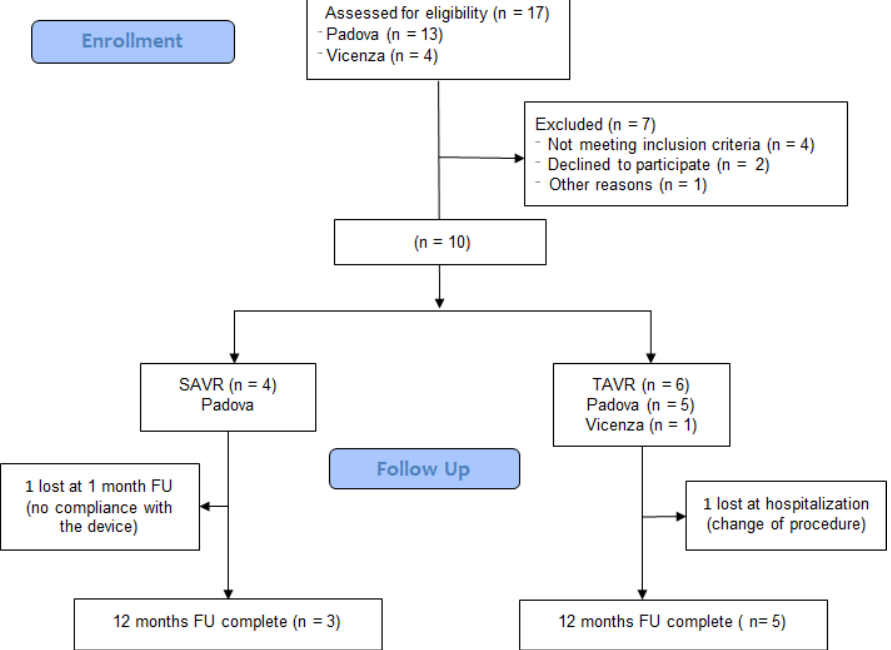
Figure 1. Flowchart of eligible patients in the two centers, Padova and Vicenza.